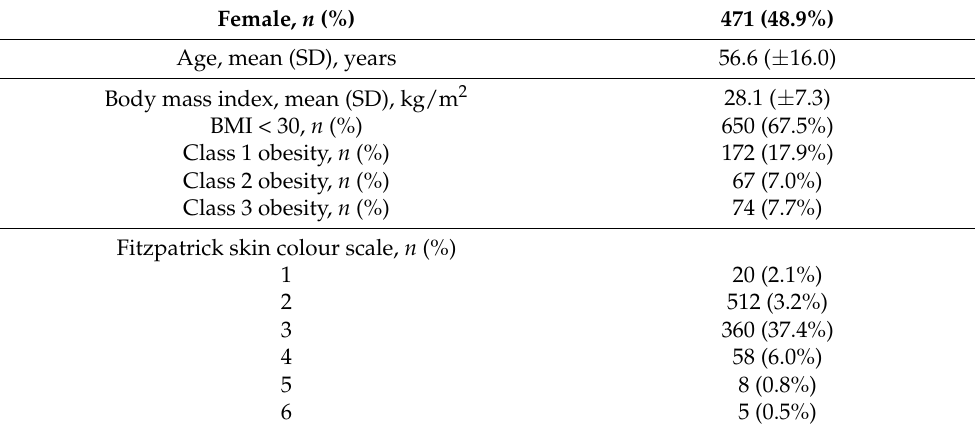
Table 1. Baseline demographic and clinical characteristics of included patients ( n = 963).